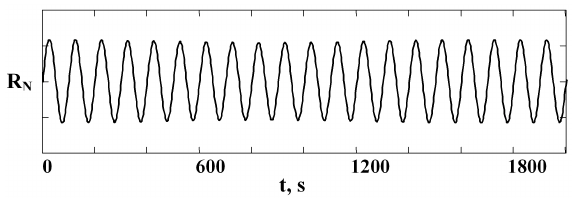
Fig. 3. Time-dependence of the wave field in the waveguide. Here t is time after the impulse.